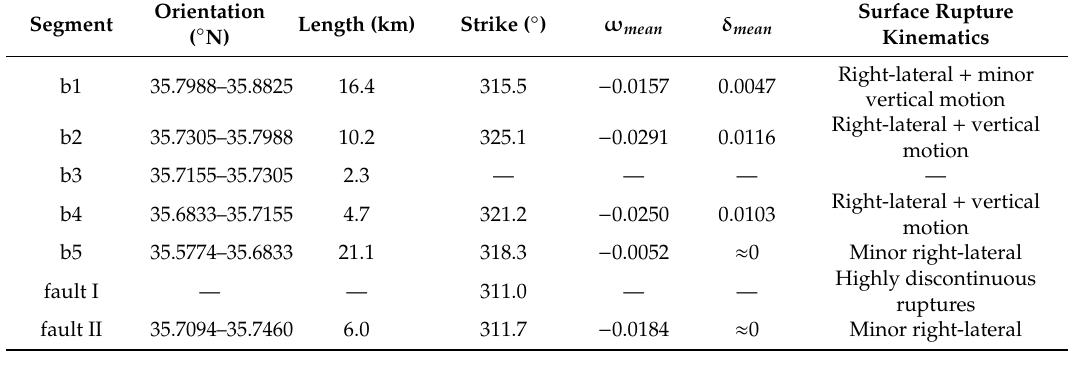
Table 1. The geometry and rupture kinematics of multiple faults derived from curl and divergence.